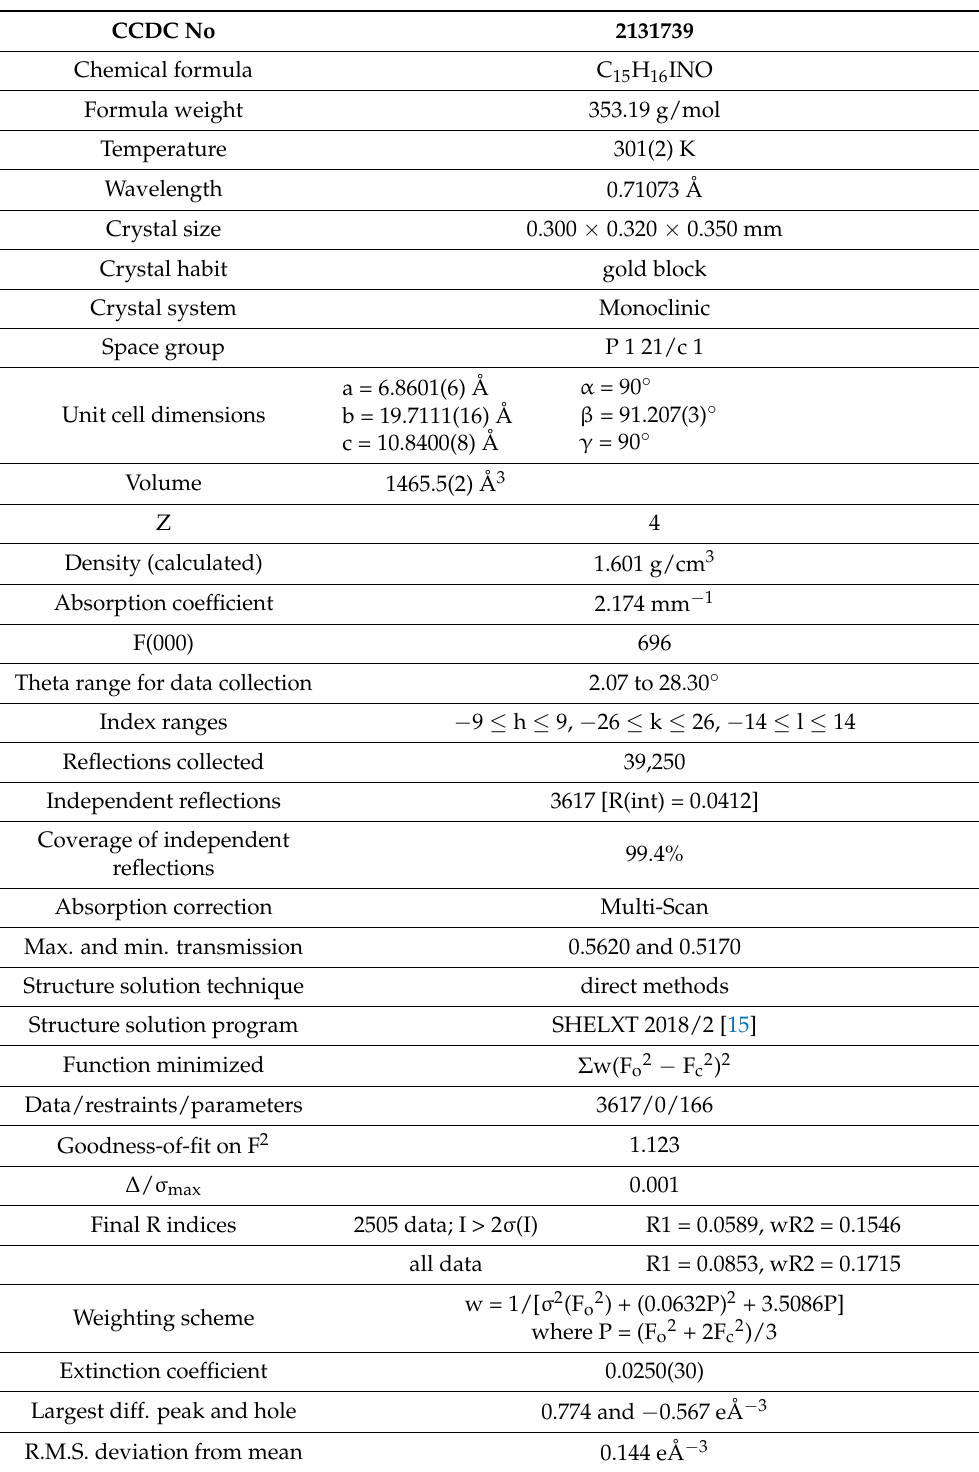
Table 1. Data collection and structure refinement for MMPI